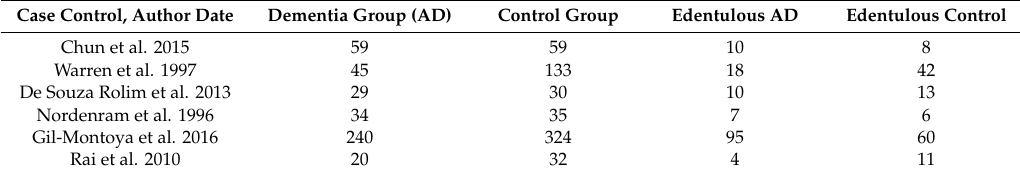
Table 3. Extracted data from selected studies (secondary outcome,